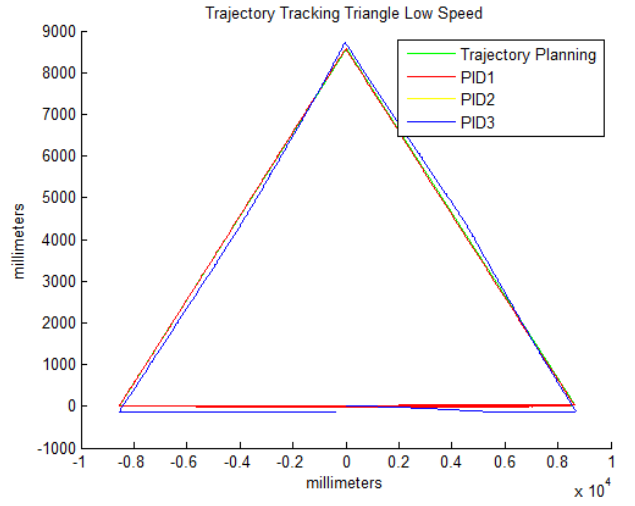
Figure 17. Trajectory Tracking of Three PID Scenarios with Triangular